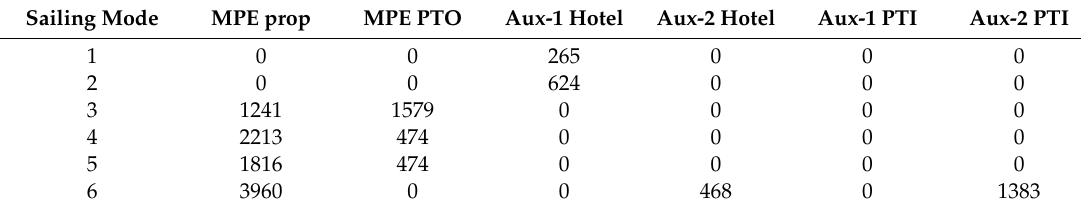
Table 8. Cargo ship: MINLP unit scheduling.